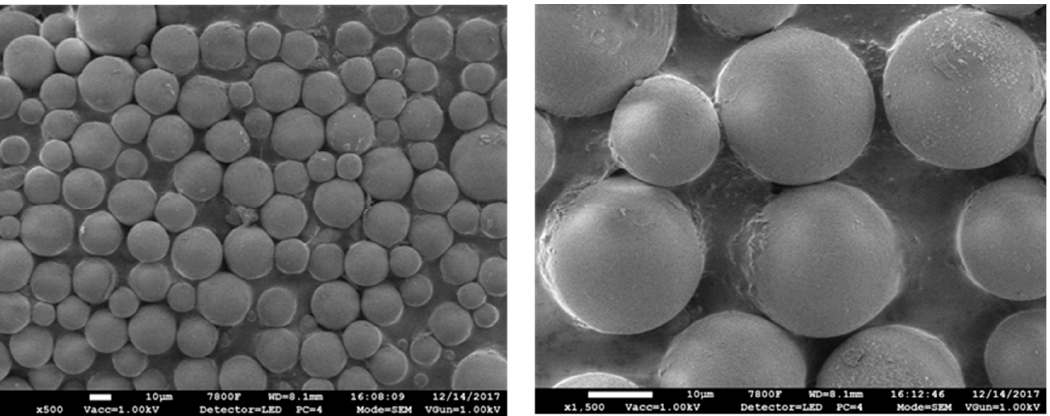
Figure 2. SEM images of poly(DEAEMA-co-DVB) microspheres.